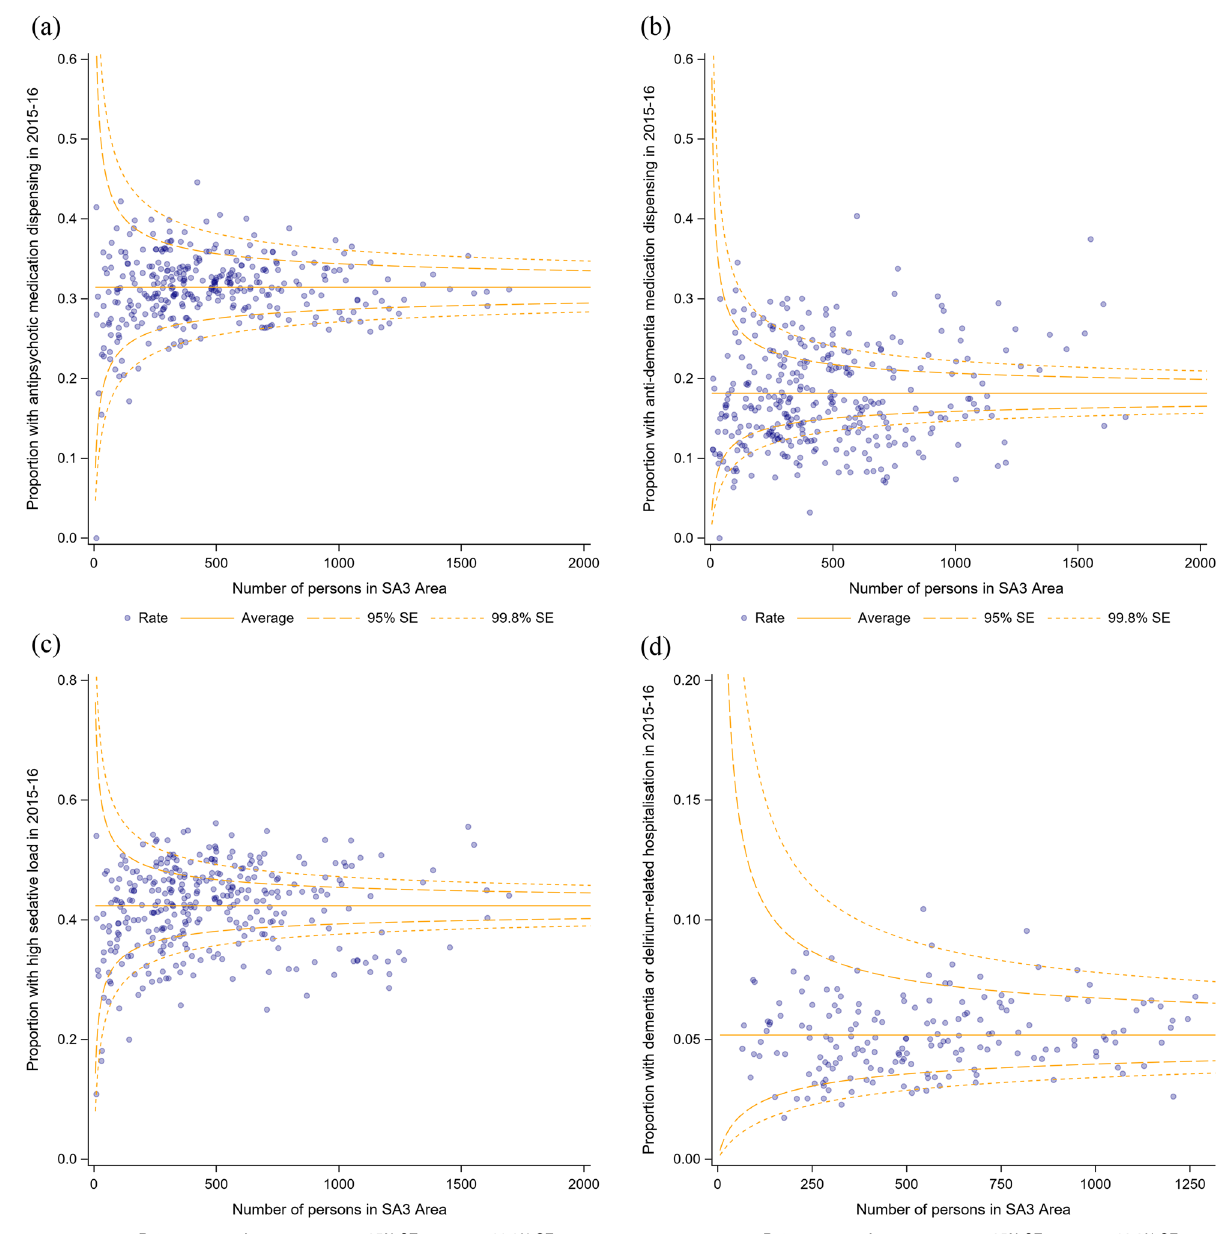
Figure 1. Adjusted geographical variation in ( a ) proportion of aged care users with dementia who were dispensed an antipsychotic medication in 2015/16; ( b ) proportion of aged care users with dementia who were dispensed a cholinesterase inhibitor or memantine in 2015/16; ( c ) proportion of aged care users with dementia with at least one 90-day period with high sedative medication load in 2015/16, and; ( d ) proportion of aged care users with dementia with a dementia or delirium-related hospitalisation in 2015/16 (New South Wales, Victoria, and South Australia